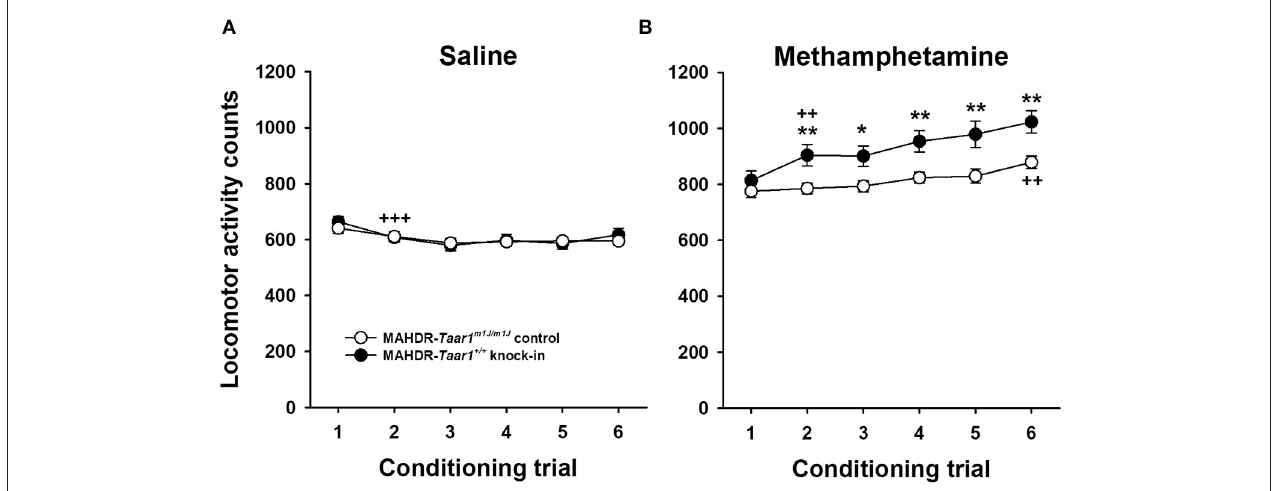
FIGURE 3 | Locomotor activity levels of saline-treated and acute MA-treated MAHDR- Taar1 + / + KI and MAHDR- Taar1 m 1 J / m 1 J control mice are comparable, but locomotor sensitization is more rapid in MAHDR- Taar1 + / + KI mice. Shown are mean ± SEM locomotor activity counts on each day of conditioning with either (A) saline or (B) MA. Mice were treated with saline or 0.5 mg/kg MA immediately prior to each 15-min conditioning trial. Mice were the same animals that generated the data in Figure 2 . * p < 0.05, ** p < 0.01 for the line difference; ++ p < 0.01, +++ p < 0.001 for the difference from the previous conditioning trial. MA, methamphetamine; MAHDR, methamphetamine high drinking mice; Taar1 + / + , homozygous reference trace amine-associated receptor 1 genotype; Taar1 m 1 J / m 1 J , homozygous mutant trace amine-associated receptor 1 genotype.